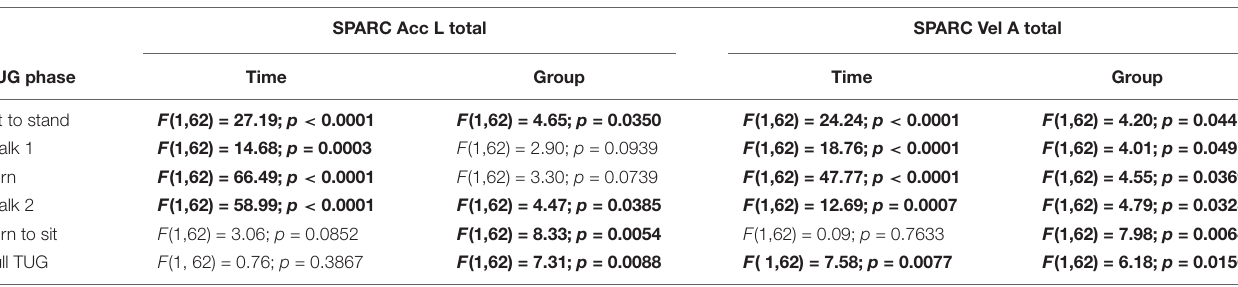
TABLE 3 | Main effects of time and group for SPARC Acc L total and SPARC Vel A